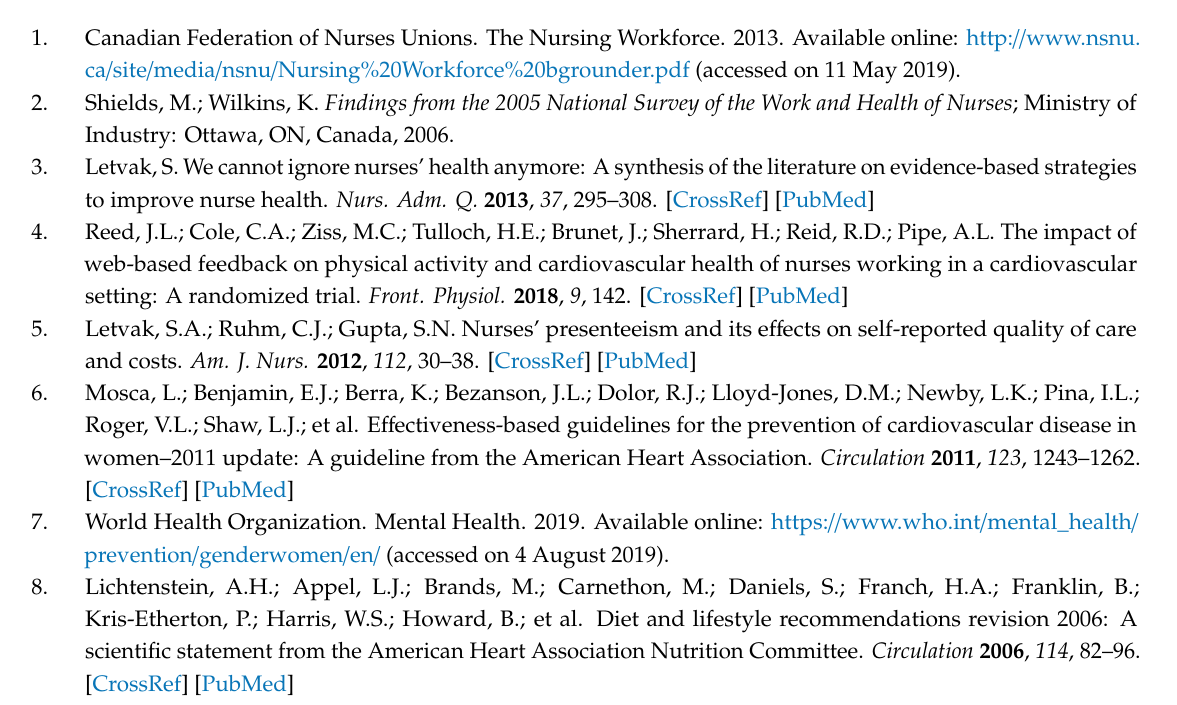
Figure S1: Correlations between dietary behaviours and anthropometric